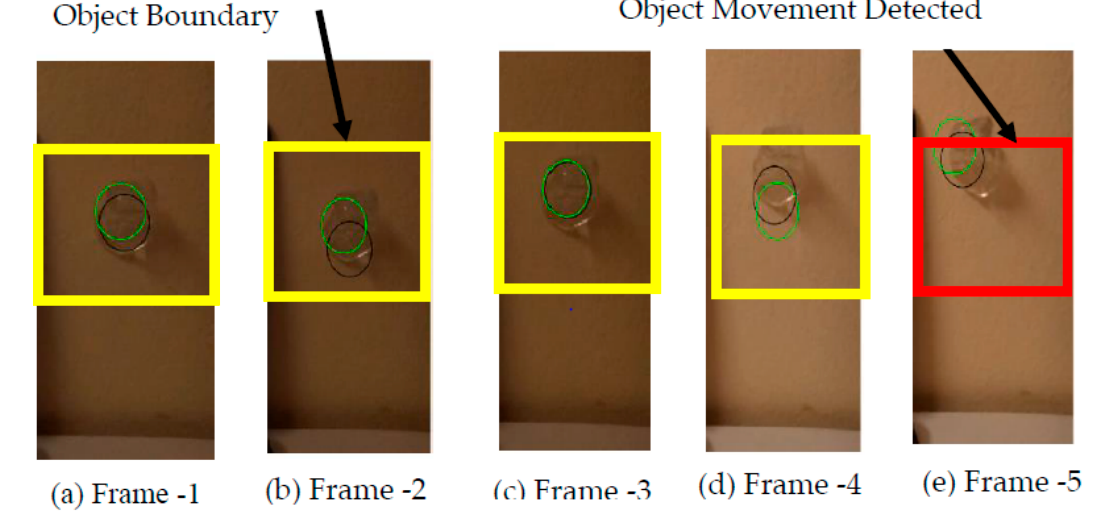
Figure 20. Tracking result of six frames.